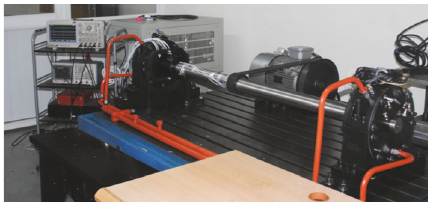
Figure 2: Overview of rotor structural health monitoring experi- mental